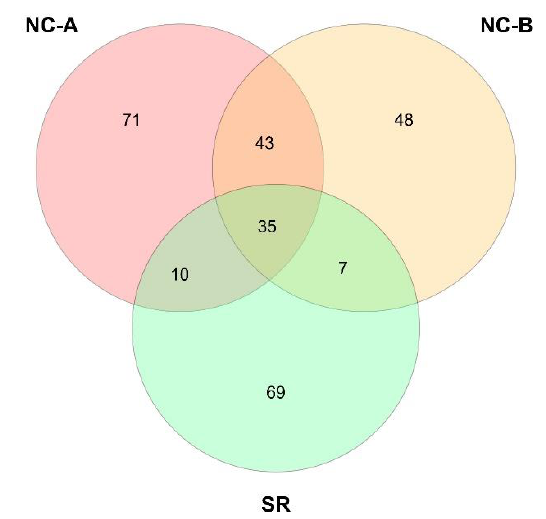
Figure 4. Venn’s diagram representing the number of OTUs identified at species level shared between NC-A, NC-B and SR plots. Table 3. List of OTUs identified at species level which were shared between the soil samples taken from Sorac á (SR) and Nuevo Col ó n (steep slope plot at higher altitude: NC-A; flat plot at lower altitude: